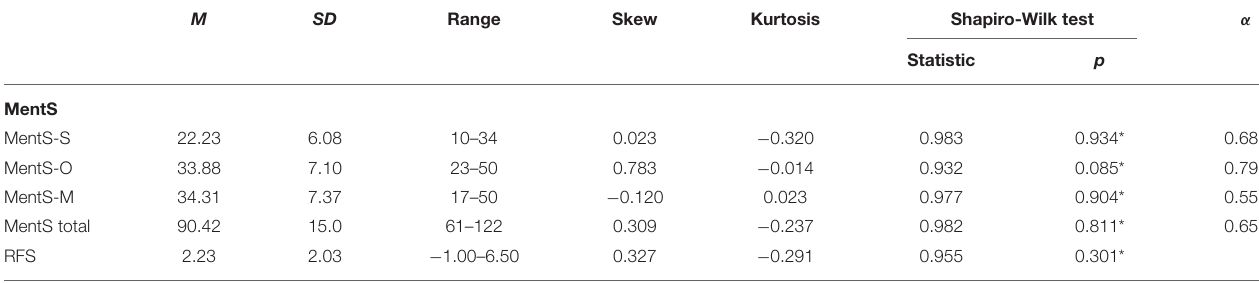
TABLE 2 | Clinical data of the sample ( N = 26). M SD Range Skew Kurtosis α